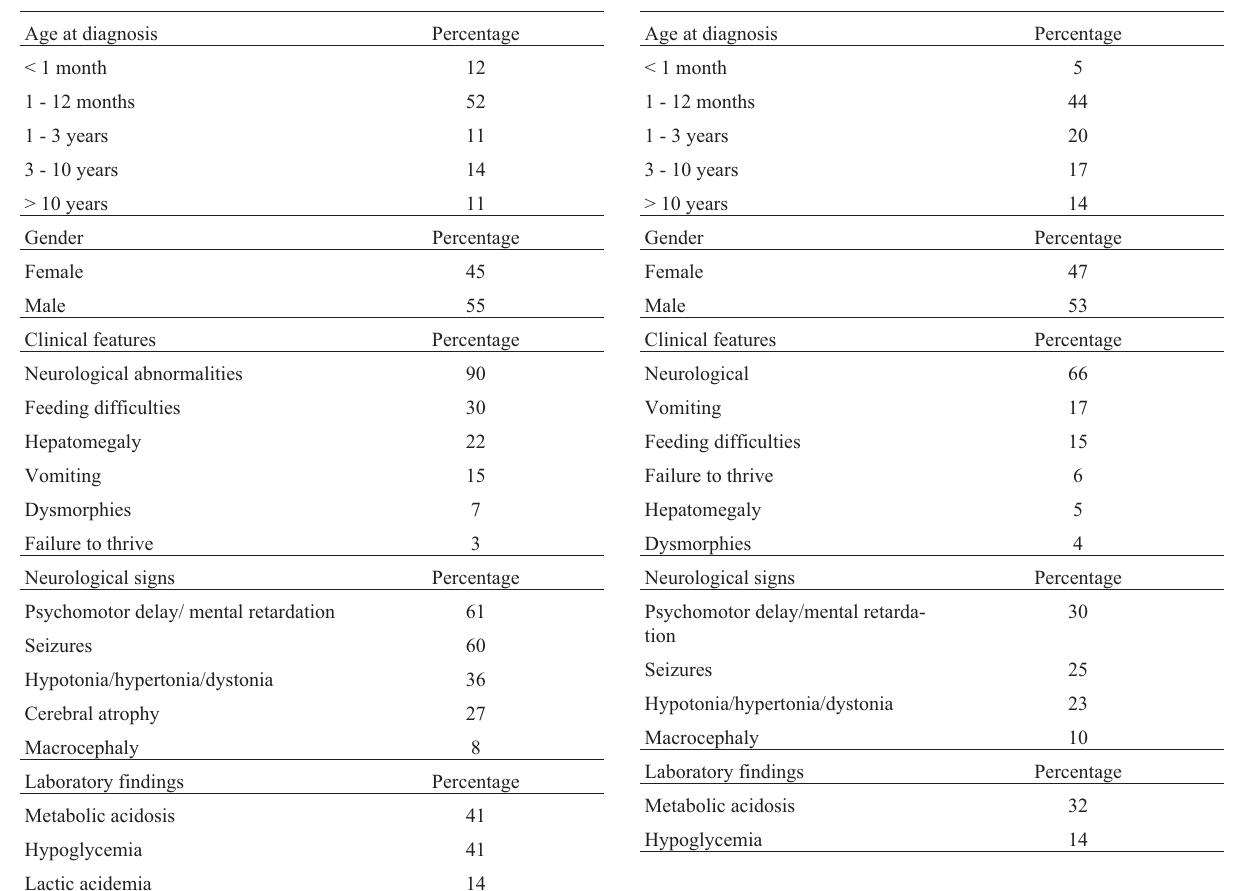
Table 2 - Common features of patients with organic acidurias detected in high-risk